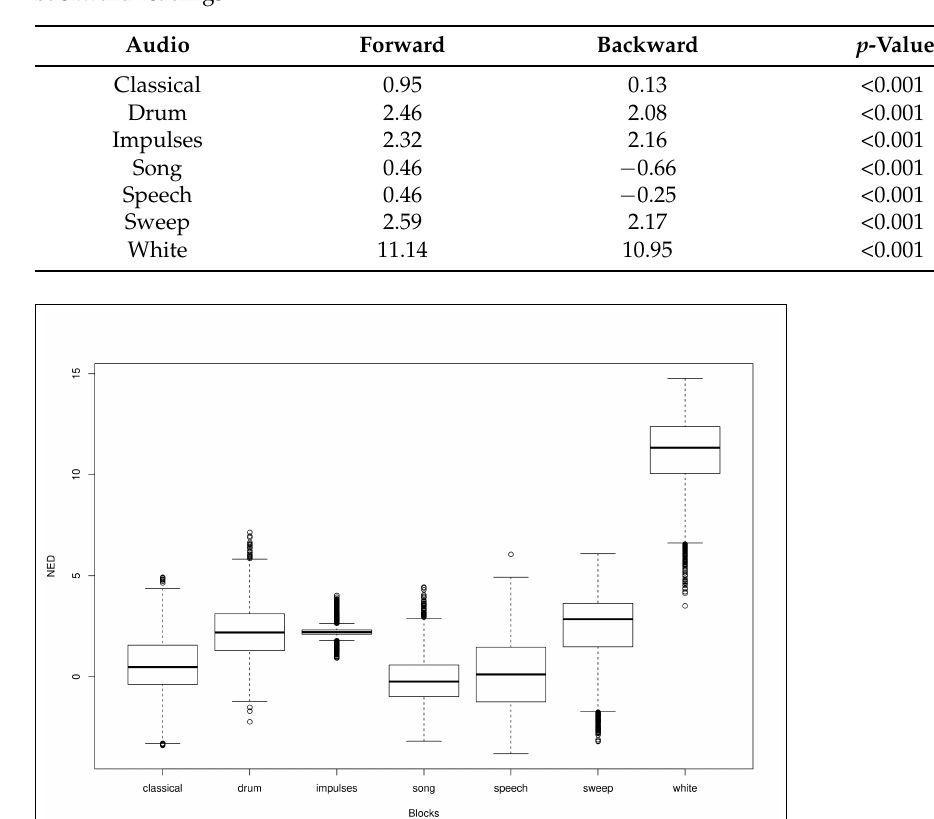
Table 4. Averages and p -values resulting from the t-test performed on the blocks of forward and backward readings.